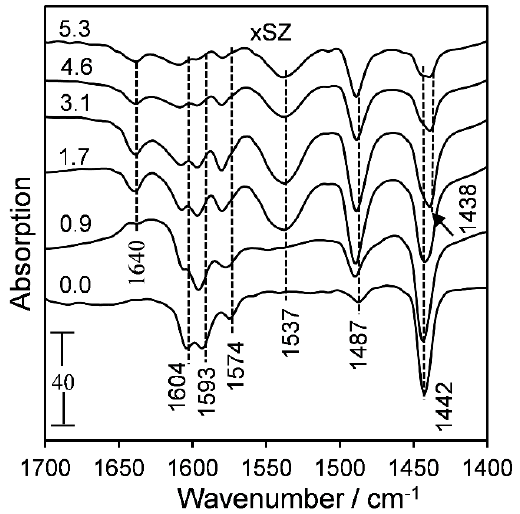
Figure 6. In situ FTIR transmission spectra of chemisorbed pyridine on parent and sulfated zirconia as a function of bulk S loading.